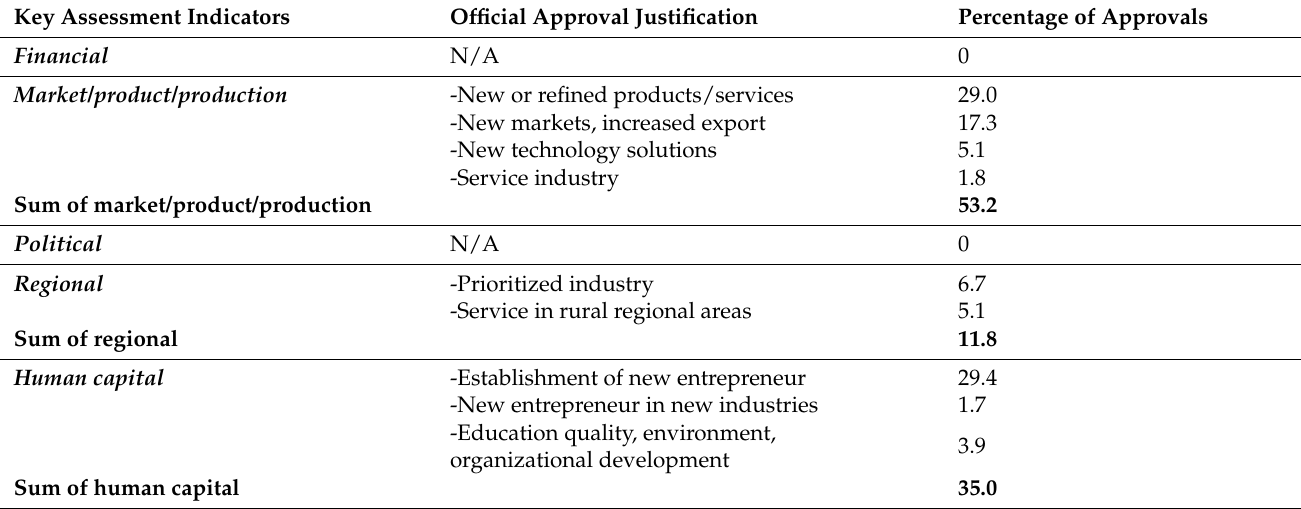
Table 2. Official justification for approving